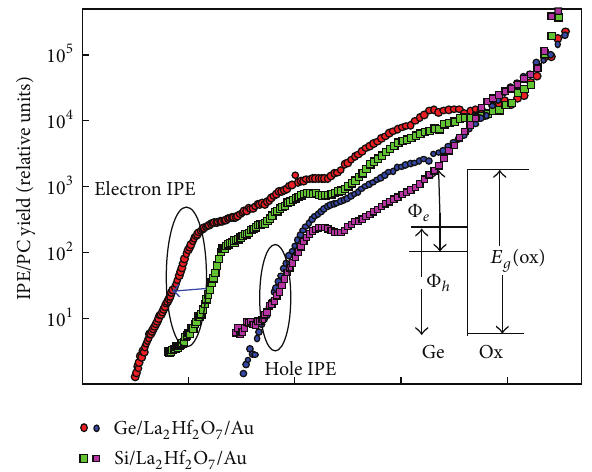
Figure 17: Semilogarithmic plots comparing electron and hole IPE spectra from Si and Ge into a 10nm thick La 2 Hf 2 O 7 insulator. The inset schematically shows the interface band diagram and illustrates the physical meaning of the observed spectral